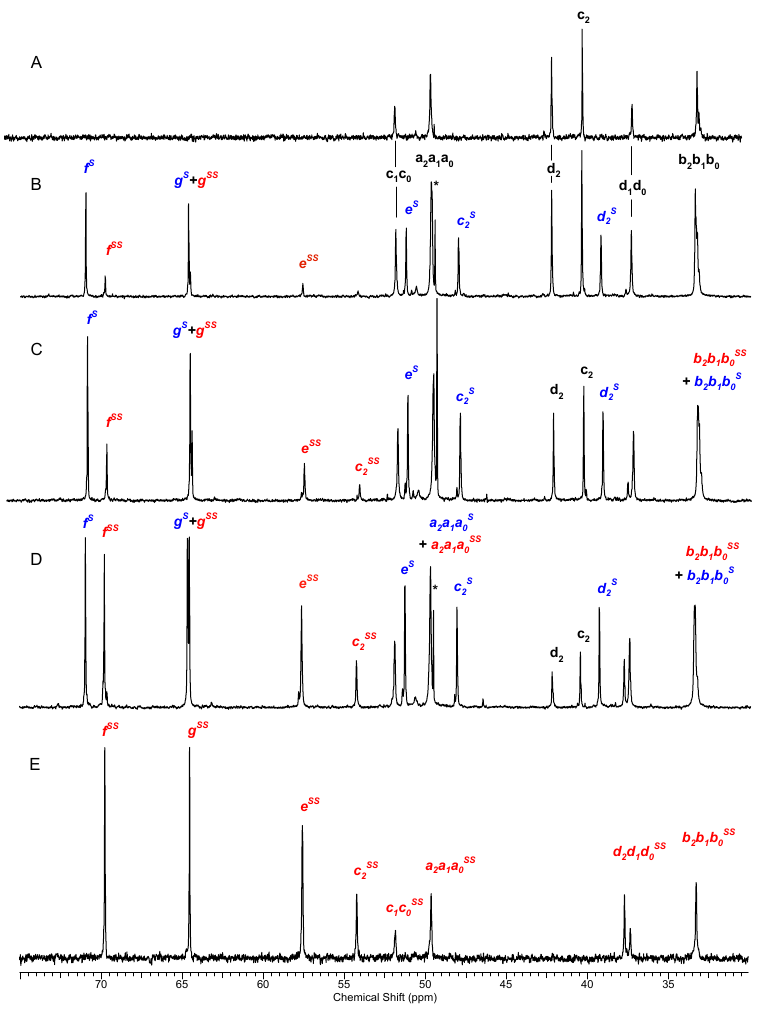
Figure 4. 13 C NMR spectra of G2 ( A ), G2 9 S gl ( B ), G2 14 S gl ( C ), G2 22 S gl ( D ), and G2 32 S gl ( E ). The carbonyl group resonances are omitted for clarity. The sharp resonance of methanol carbon at 44.3 ppm is labeled with an asterisk.